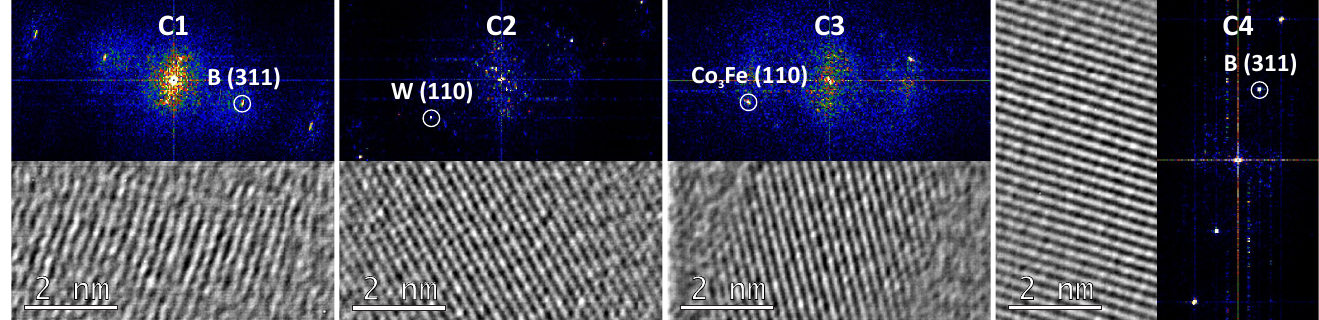
Figure 4. 2D Fourier transformation of the corresponding areas labeled as C1, C2, C3 and C4 in the HRTEM image of the sample W-100 presented in Figure 3f. The areas C1 and C4 were identified as tetragonal B phase. Cubic phases bcc-W and bcc-Co 3 Fe were identified in areas C2 and C3, respectively. Numbers in brackets represents Miller indices of visualized atomic plane system.